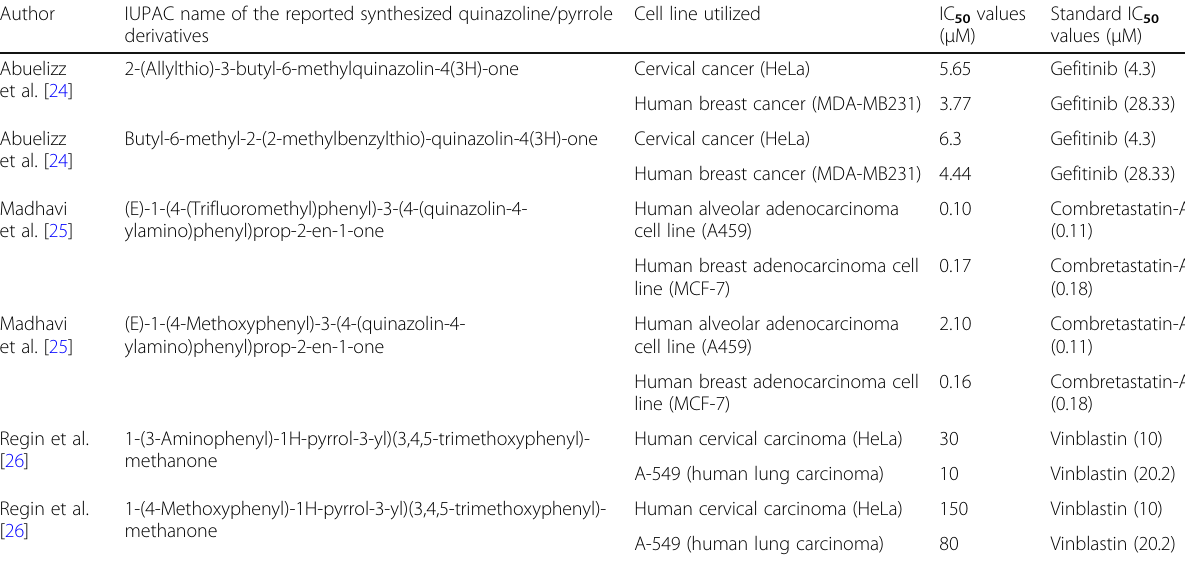
Table 1 Anticancer activity of few previously reported quinazoline and pyrrole base derivative